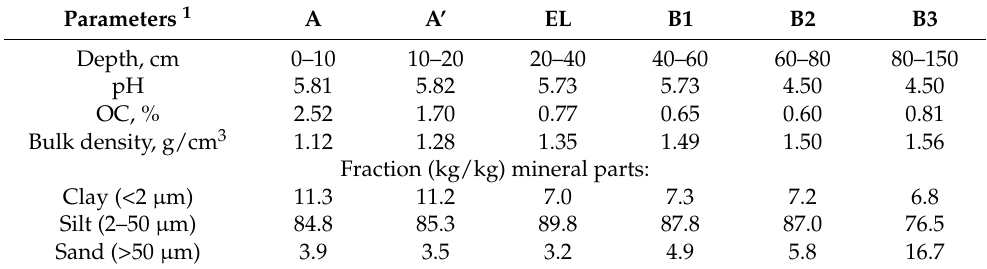
Table 1. Some chemical and physical properties of the Albic Glossic Retisol of lysimeter.